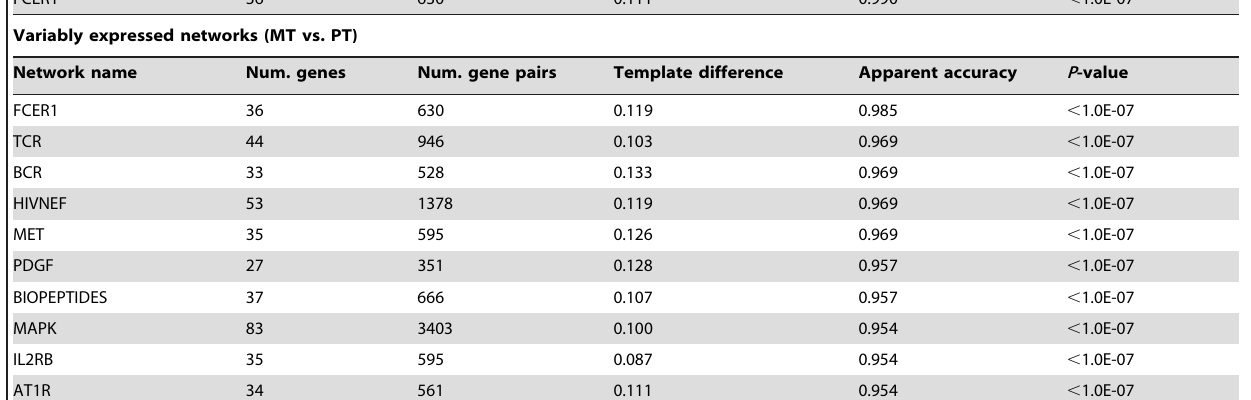
Variably expressed networks (MT vs.